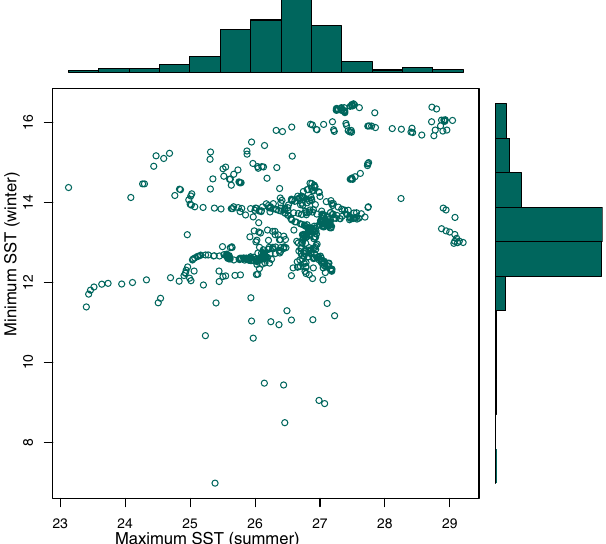
Figure 1. Sea surface temperatures (SST) at which Posidonia oceanica meadows are found in the Mediterranean Sea according to the locations compiled in this study. The figure illustrates the high seasonality between summer and winter. Fewer presence records occur in marginal conditions of SST below 10 °C or above 28